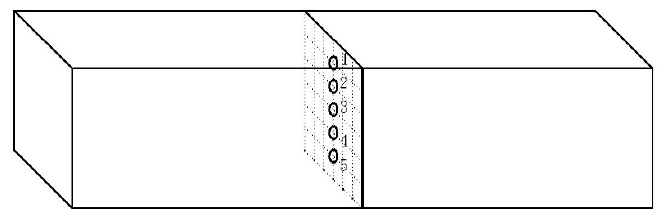
Figure 1. Diagram of the wood tested sample and location of the sensors. (1 is the upper layer measuring point; 2 is the upper middle layer measuring point; 3 is the core layer measuring point; 4 is the lower middle layer measuring point; and 5 is the lower layer measuring point).